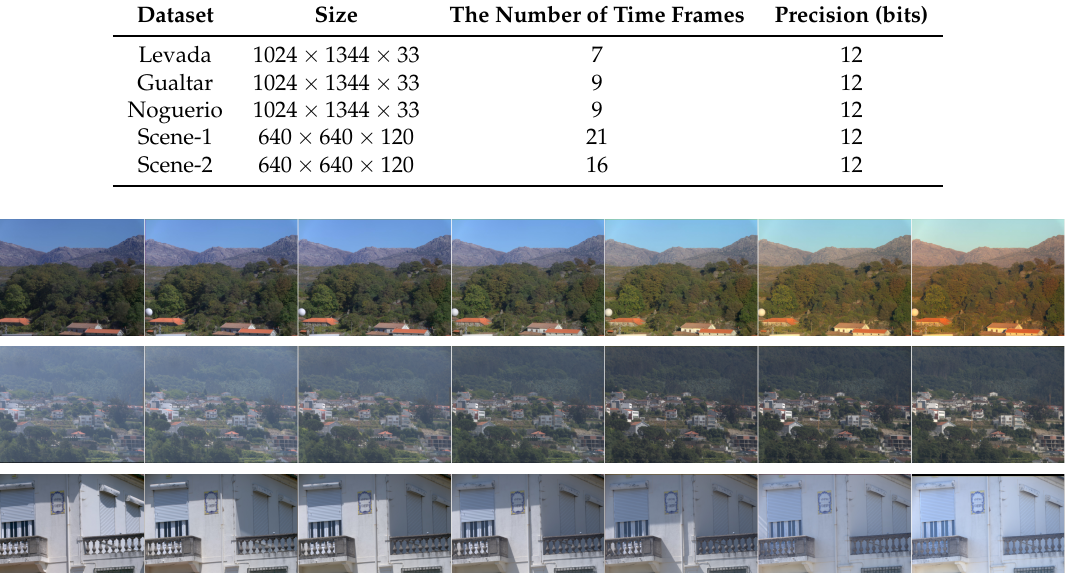
Figure 2. Some sample images at different time instants from the time-lapse hyperspectral image datasets (from top to bottom: Levada, Nogueiro and